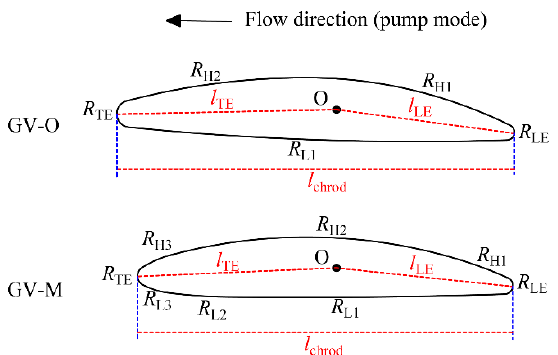
Figure 4. Airfoil profiles and parameter definitions of GV-O and GV-M.